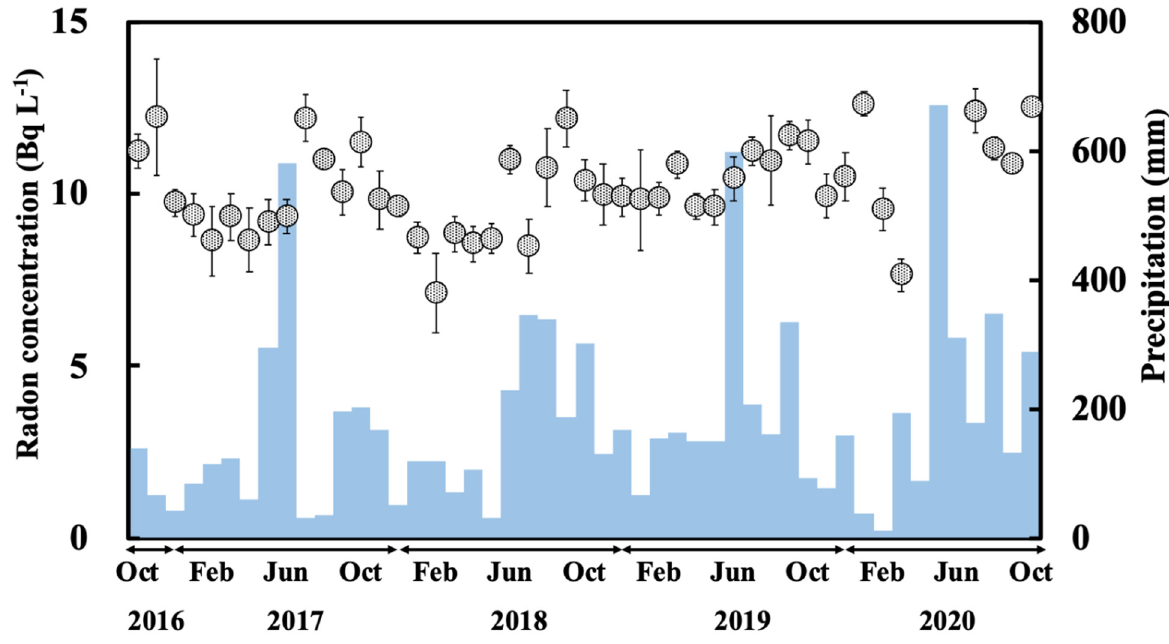
Figure 5. Variation of radon concentrations for the dripping water sample from the Gyokusendo cave compared to the monthly precipitation obtained from AMeDAS (Itokazu) for the study period.